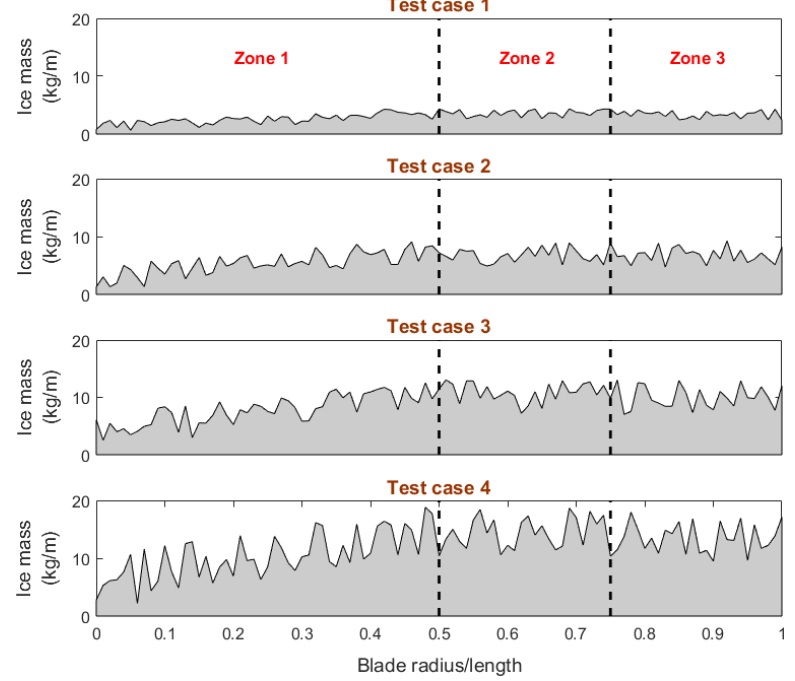
Figure 18. Ice mass distributions considered along the blade length in the four test cases. Table 9. Ice masses identified in the test